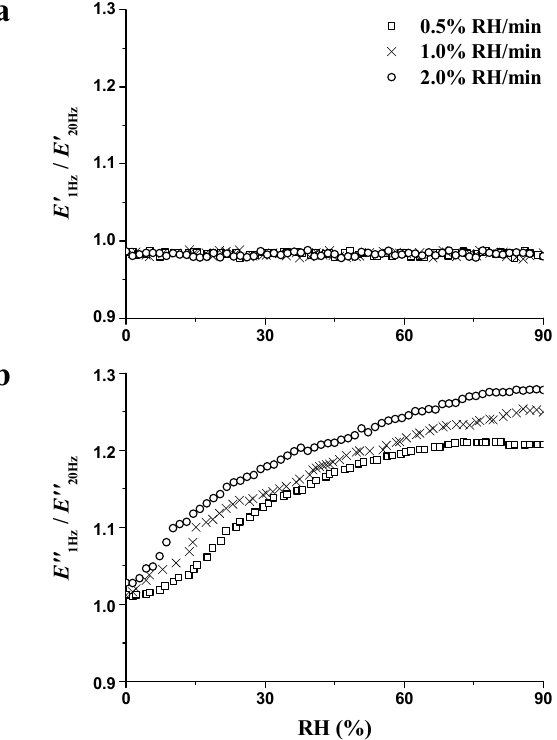
Figure 7. Influence of RH on E ′ 1Hz / E ′ 20Hz ( a ) and E ″ 1Hz / E ″ 20Hz ( b ) during the RH ramp period (0% → 90% RH) with different RH ramping rates.